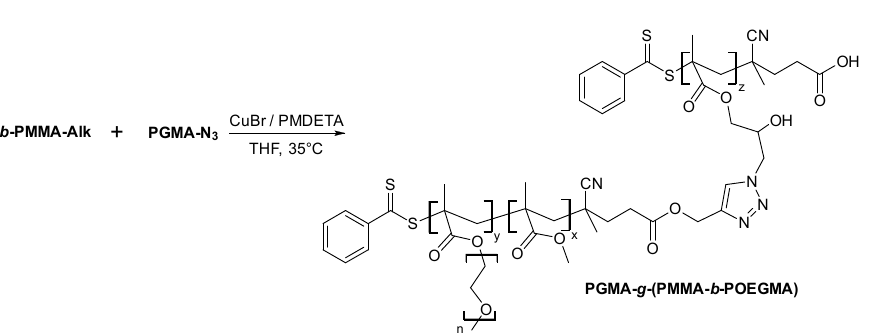
Scheme 4. Synthesis of block copolymer brush (PGMA- g -(PMMA- b -POEGMA)).